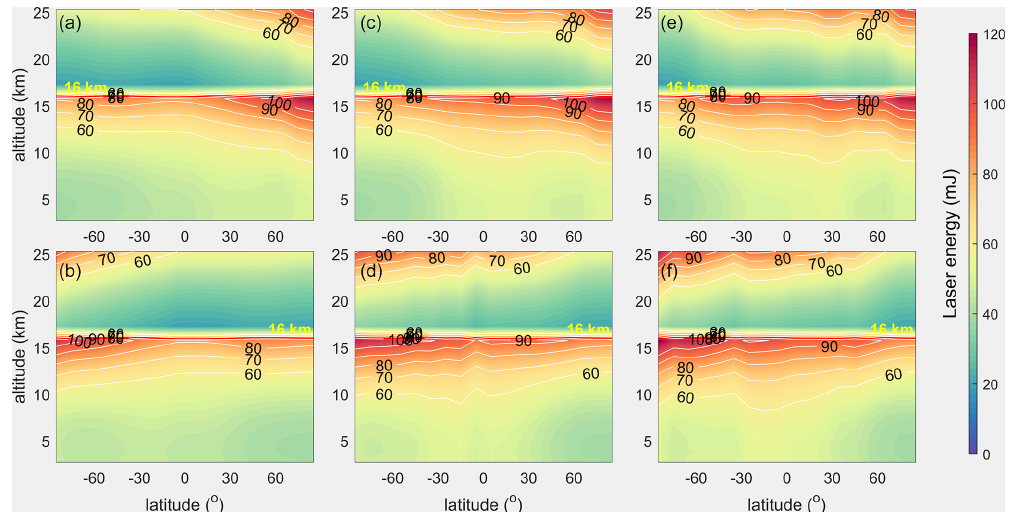
Figure 7. The global distributions of the required laser pulse energies in the troposphere and the stratosphere to reach the accuracy require- ments of the ESA. The arrangement of the subgraphs corresponds to that of Fig. 2. Table 2. The quantiles of the required laser pulse energy of the three spaceborne DWLs to meet the accuracy requirements of the ESA. Quantile (%) Required energy Orbit